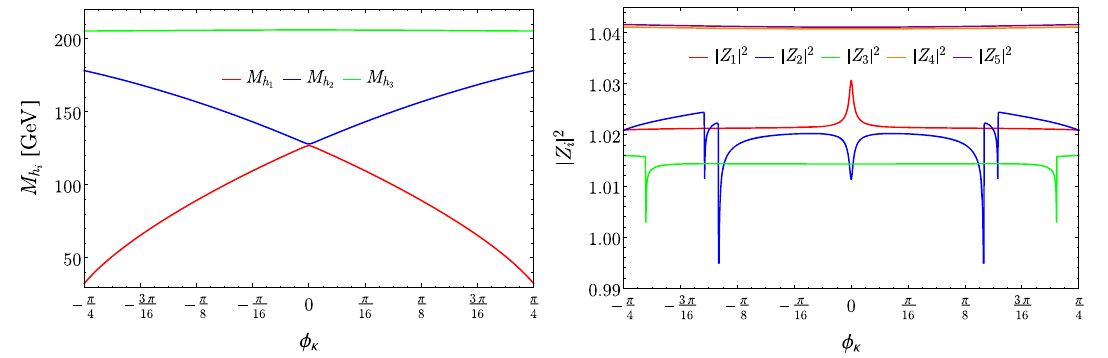
Fig. 10 On the left-hand side , the masses of the three lighter Higgs states are depicted as a function of φ κ , including all available two- loop contributions. On the right-hand side , the squared norms | Z i | 2 [as defined in Eq. (2.38)] of the five eigenvectors defining Z mix are